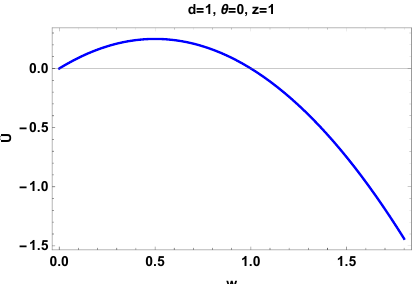
Figure 9 . The effective potential ˆ U ( w ) is independent of λ , and there is a maximum inside the horizon at w fB = 1